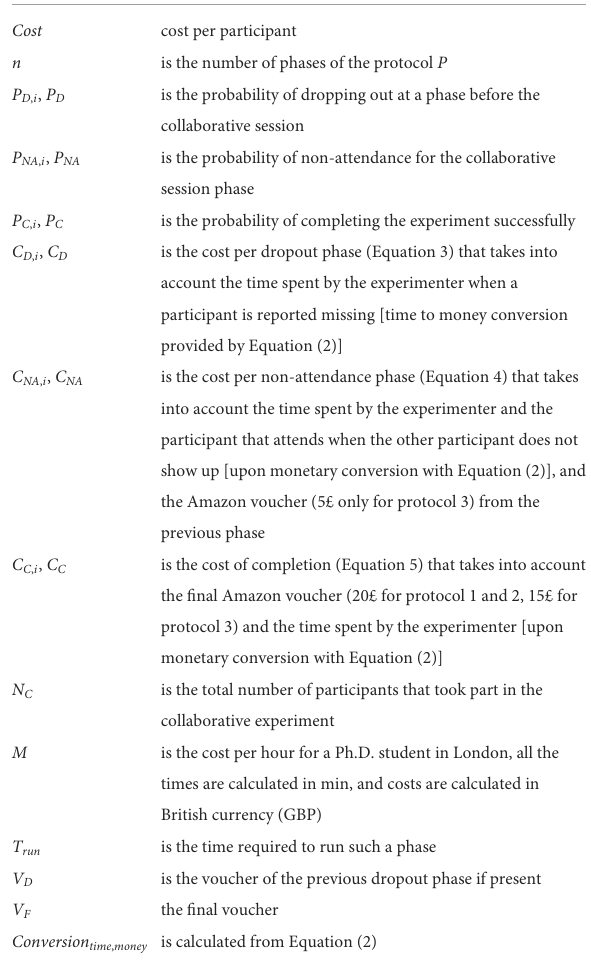
TABLE 1 Equation